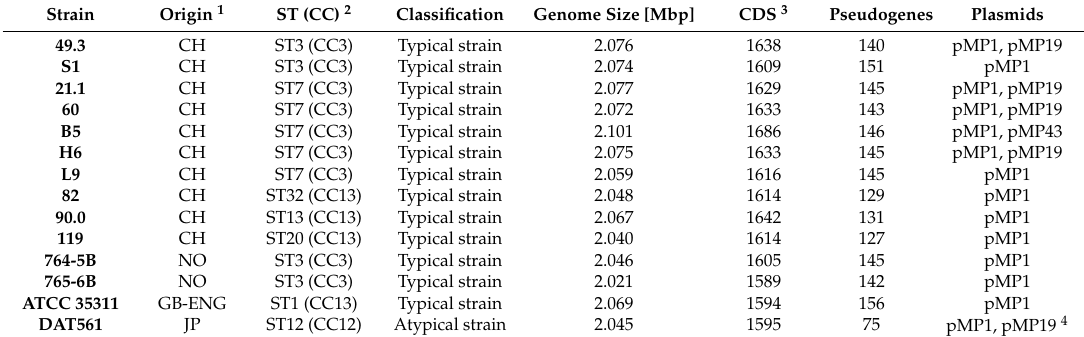
Table 1. General data of M. plutonius strains used in this